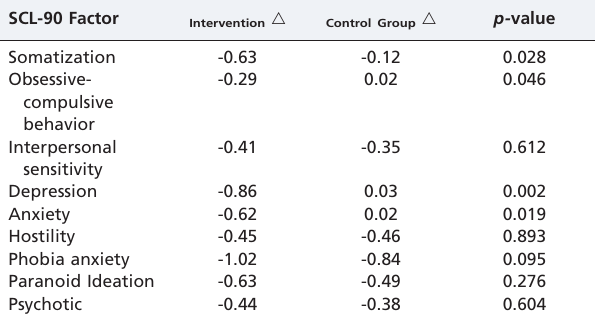
Table 4 - Between-group comparisons of the mean SCL-90 difference